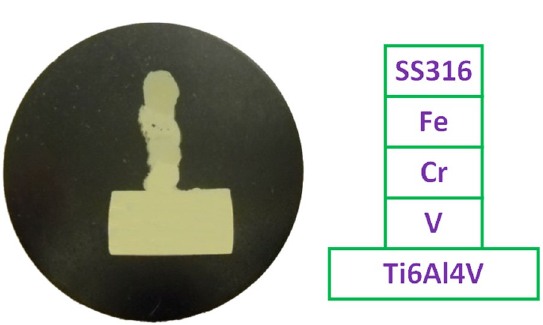
Figure 6. Thin wall multi-metallic sample.